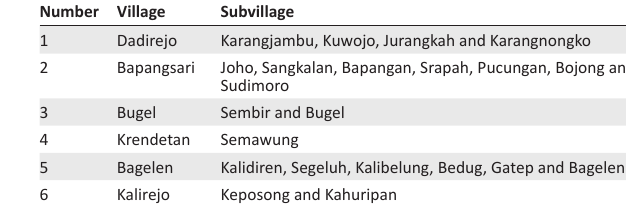
TABLE 1: List of subvillages affected by flood